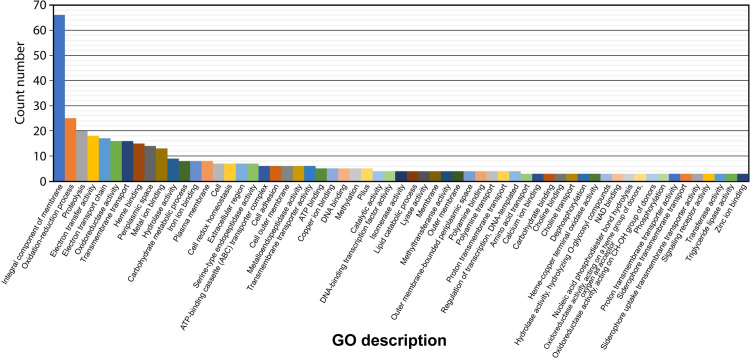
Gene Ontology (GO) descriptions of predicted extra-cytoplasmic proteins with an even number of cysteines.The highest frequency of proteins with an even number of cysteines are integral components of membranes (66 proteins), followed by proteins involved in redox (oxidation-reduction) processes (25 proteins) and proteolysis (20 proteins). For ease of representation and clarity, GO descriptors with less than three counts were excluded from this graph. A complete graph, along with raw values can be found in S1 File.